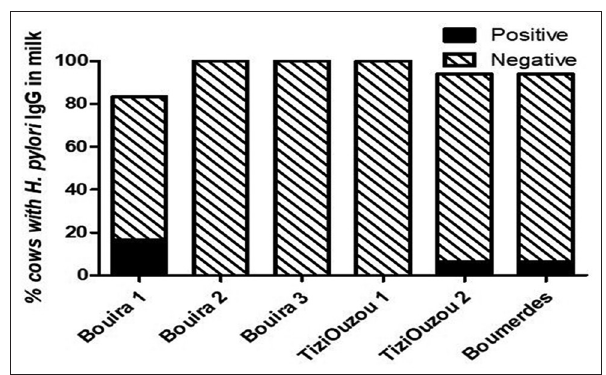
Figure-1: Occurrence of Helicobacter pylori among cows’ milk samples using enzyme-linked immunosorbent assay by region.